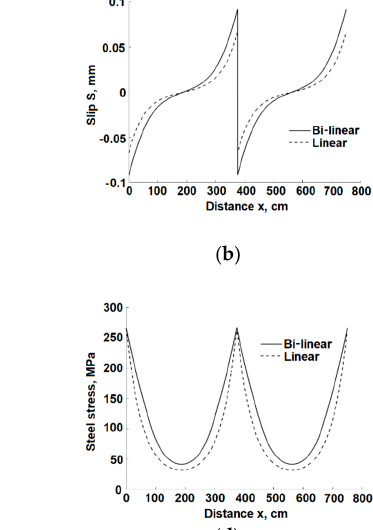
Figure 12. Concrete and rebar displacements along half-length of the element after the 1st cracking stage. ( a ) Rebar; ( b ) Concrete.